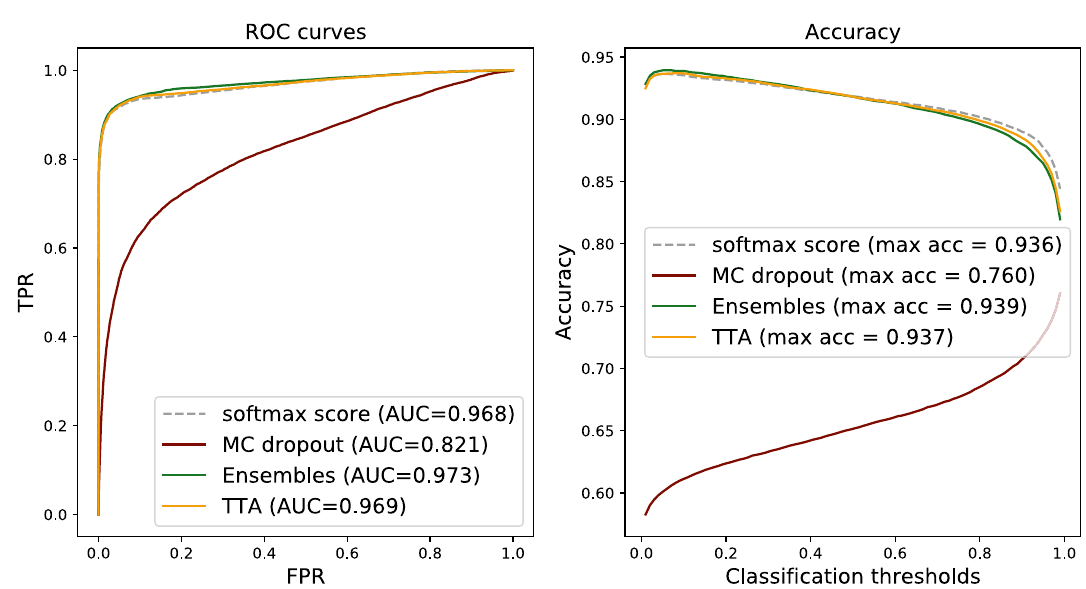
Figure 2. Tumour metastases detection on BRLN data: ROC curves and accuracy of using softmax tumour score from a single NN vs averages of softmax tumour scores (per input) produced by the uncertainty estimation